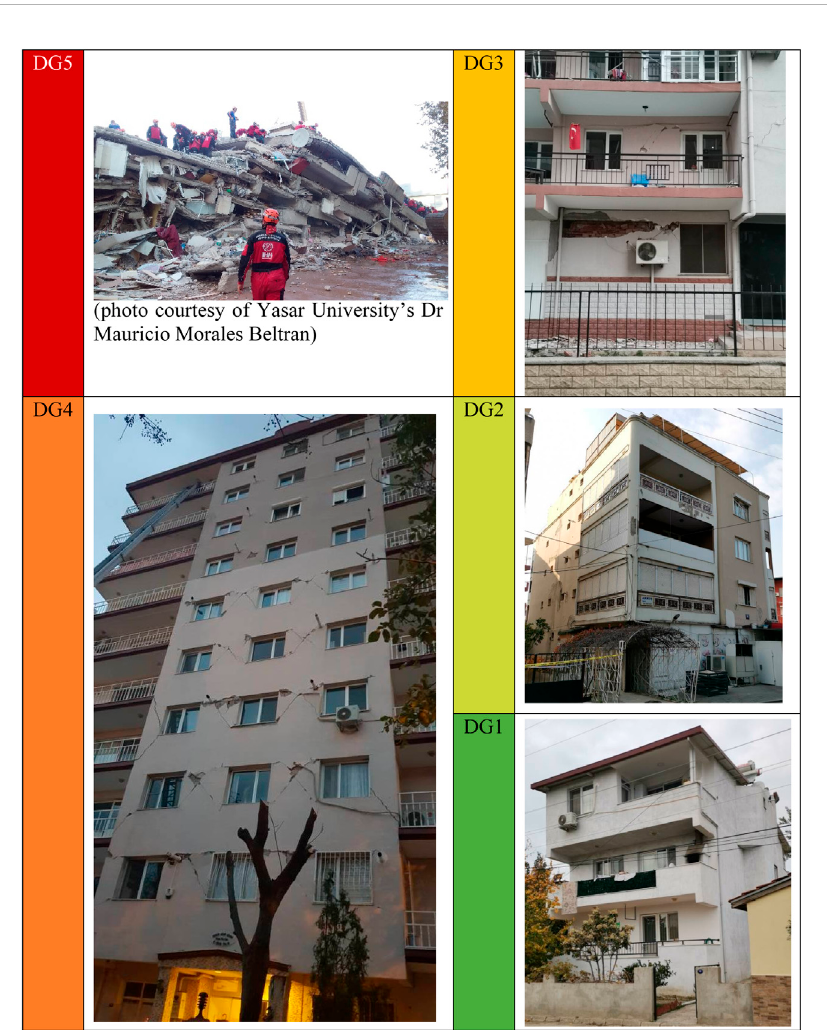
TABLE 3 | Examples of RC structures at different damage classes (all in Izmir, Turkey).